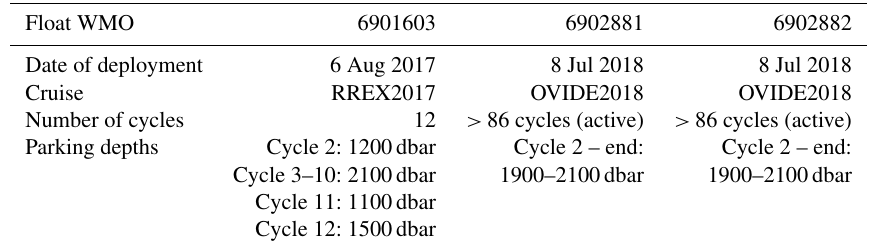
Table 2. Details on the deployment and parking depth of the three Deep-Arvor floats.